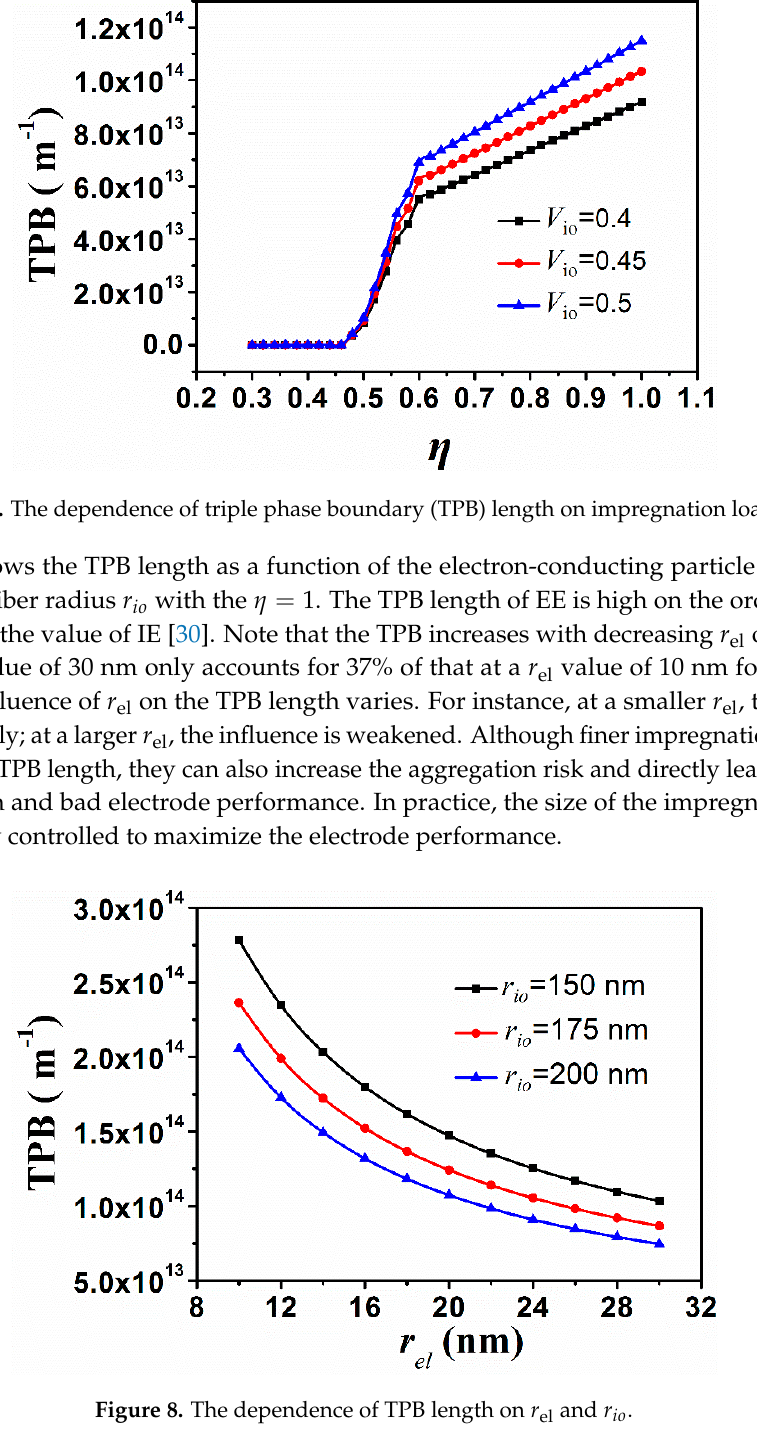
Figure 8. The dependence of TPB length on